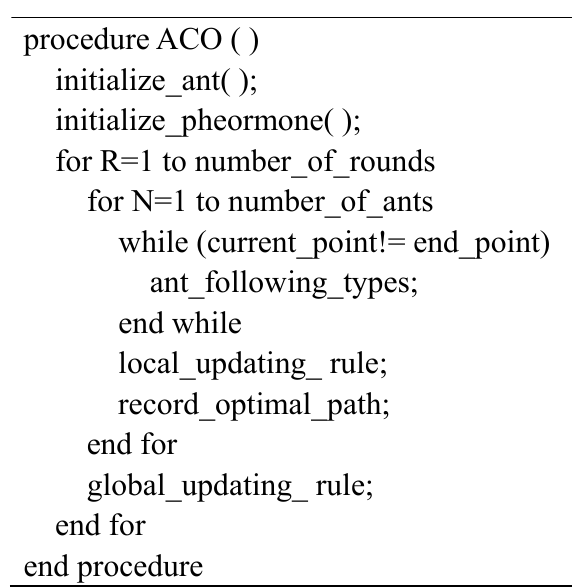
Figure 4. The procedure of modified ACO